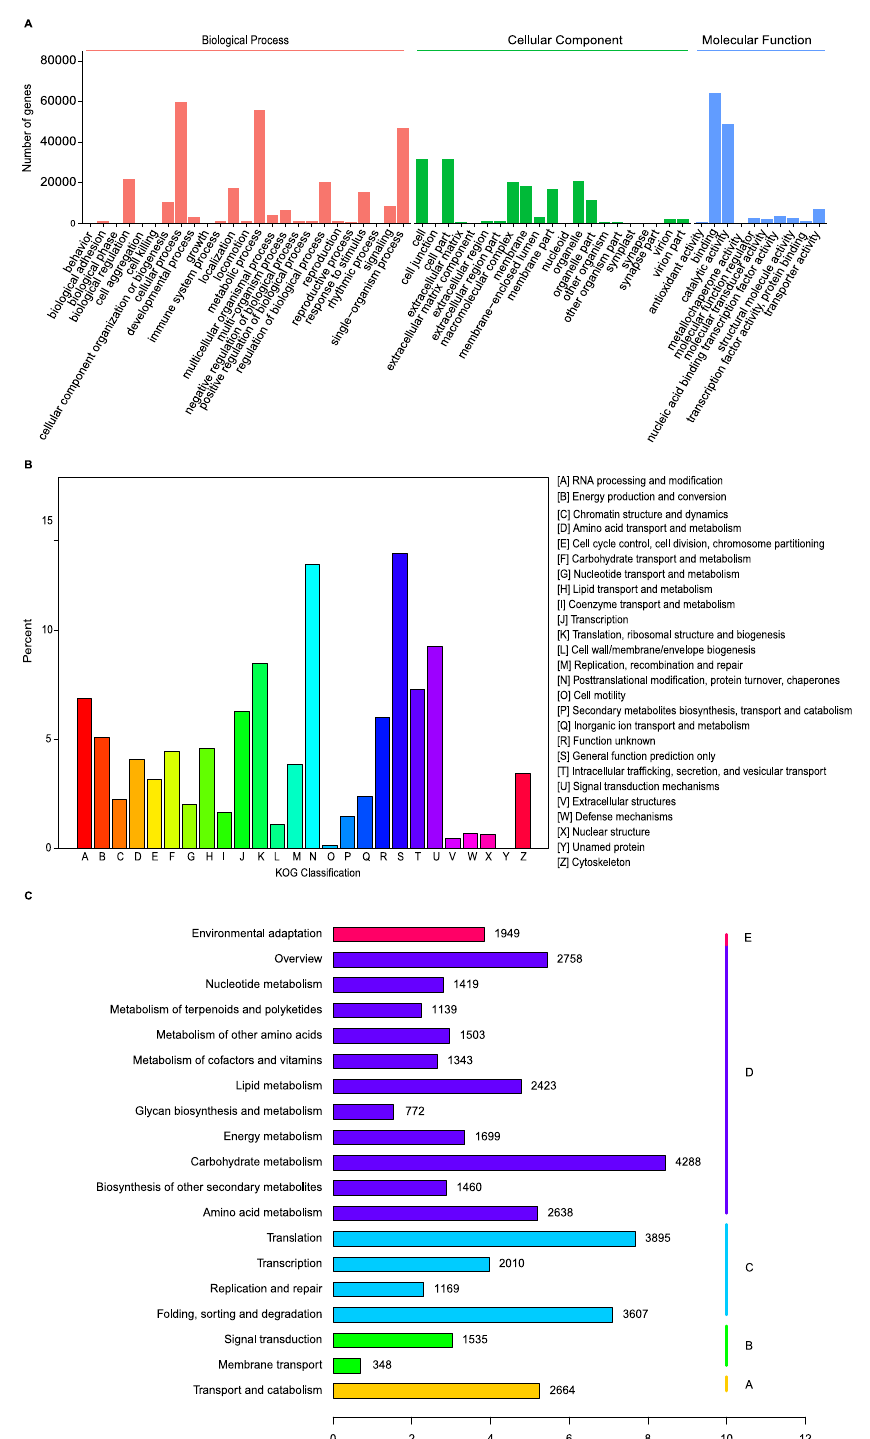
Fig 3. Gene ontology (GO), KOG and KEGG analysis of unigenes. (A) Gene ontology (GO) categorization of unigenes. Different colors represent the three main gene ontology categories; ‘Biological Process’ is indicated in red, ‘Cellular Component’ in green, and ‘Molecular Function’ in blue; (B) KOG function classification; (C) KEGG annotation of unigenes. Different colors represent different KEGG classification, including Cellular Processes (A), Environmental Information Processing (B), Genetic Information Processing (C), Metabolism (D) and Organismal Systems (E).